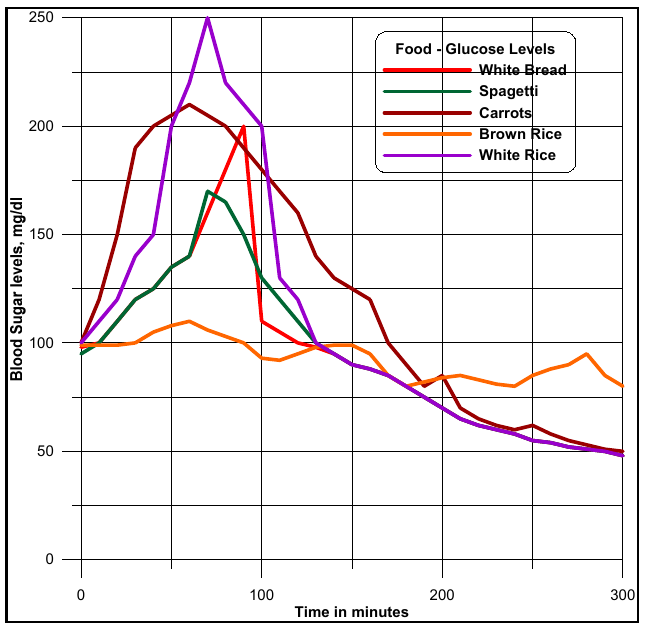
Figure 22. Blood glucose levels for different food types.